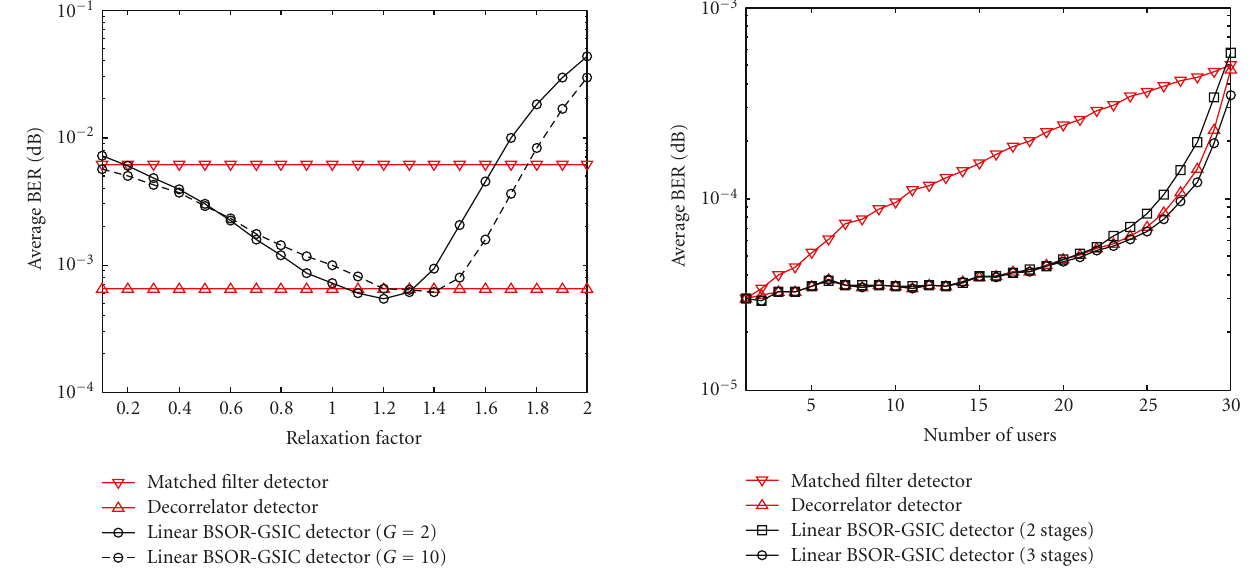
Figure 7: Capacity of the chip-level linear BSOR-GSIC detector for G = 2.